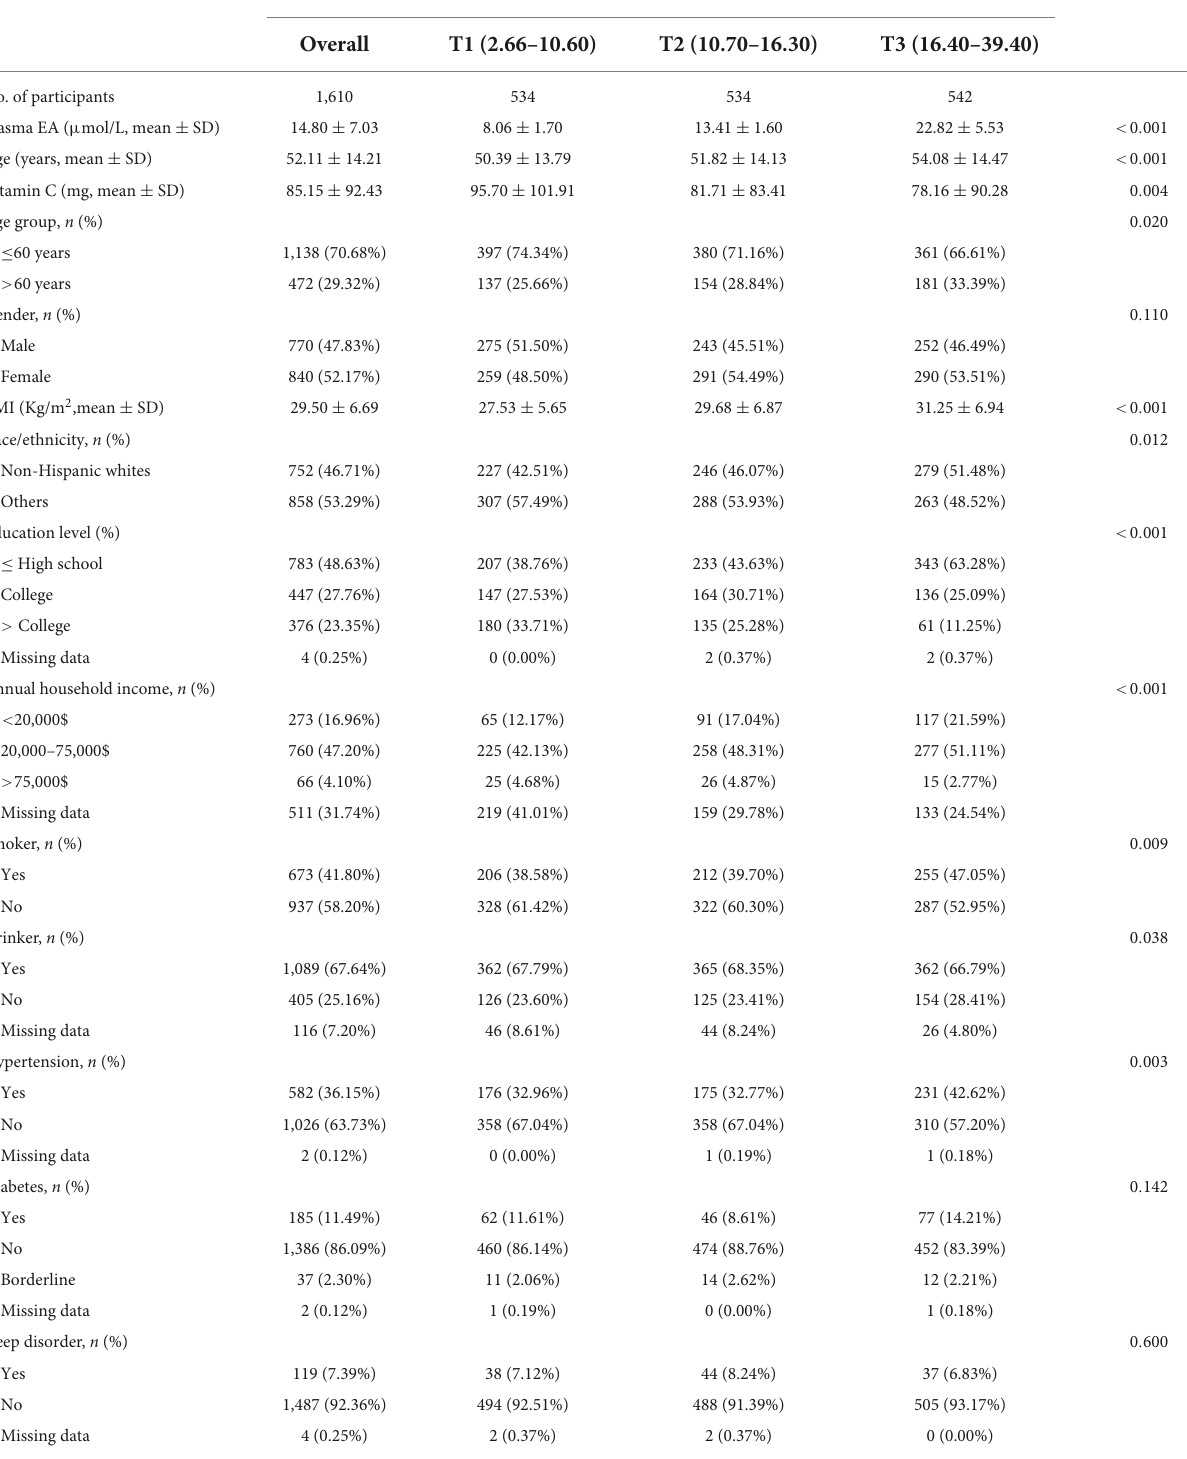
TABLE 1 Characteristics of participants ( N =